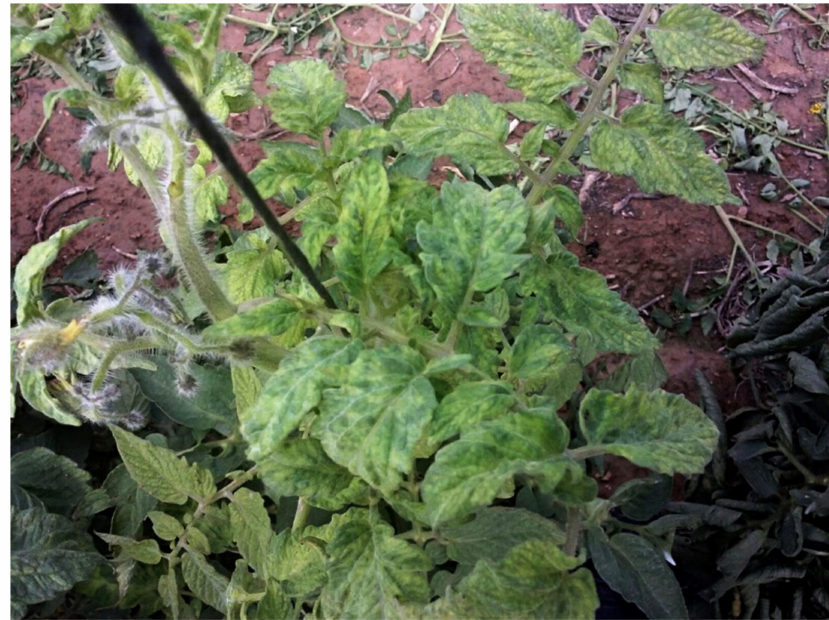
Figure 14. Leaf green spot mosaic with yellow spots induced by Tomato mosaic